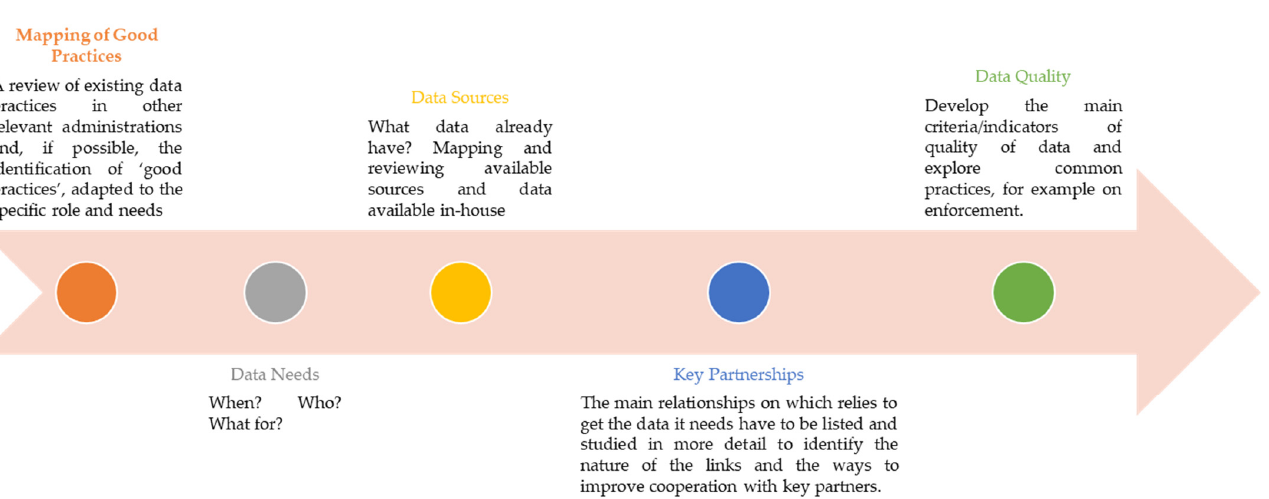
Figure 4. Data collection steps.